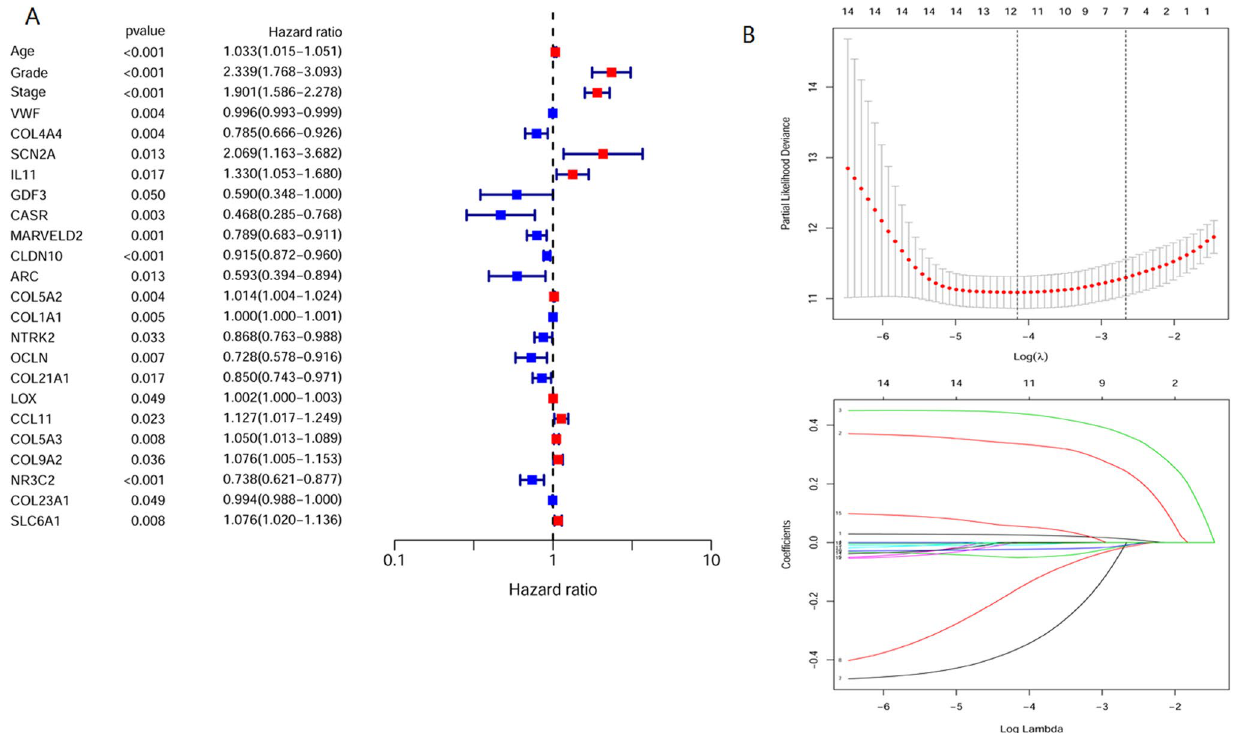
Figure 4. Screening prognostic factors and model construction. ( A ) Univariate Cox regression was used to screen 24 factors associated with KIRC prognosis, including three clinical features and 21 key genes. Blue in the figure indicates a negative correlation, and red indicates a positive correlation. ( B ) Parameter selection and coefficient determination for model construction. Seven key factors were filtered by lambda. Model construction for the LASSO regression included: age, grade, stage, GDF3, CASR, CLDN10, and COL9A2. The coefficient distribution plot calculates a coefficient for each gene, indicating each factor’s weight in the